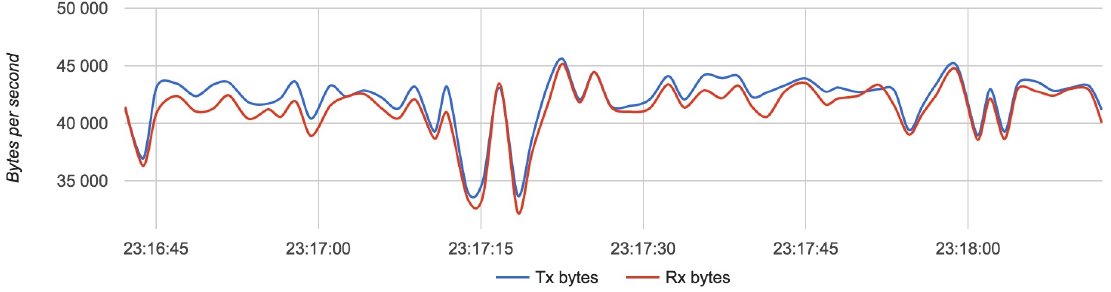
Figure 21. Bandwidth usage for a router with Configuration